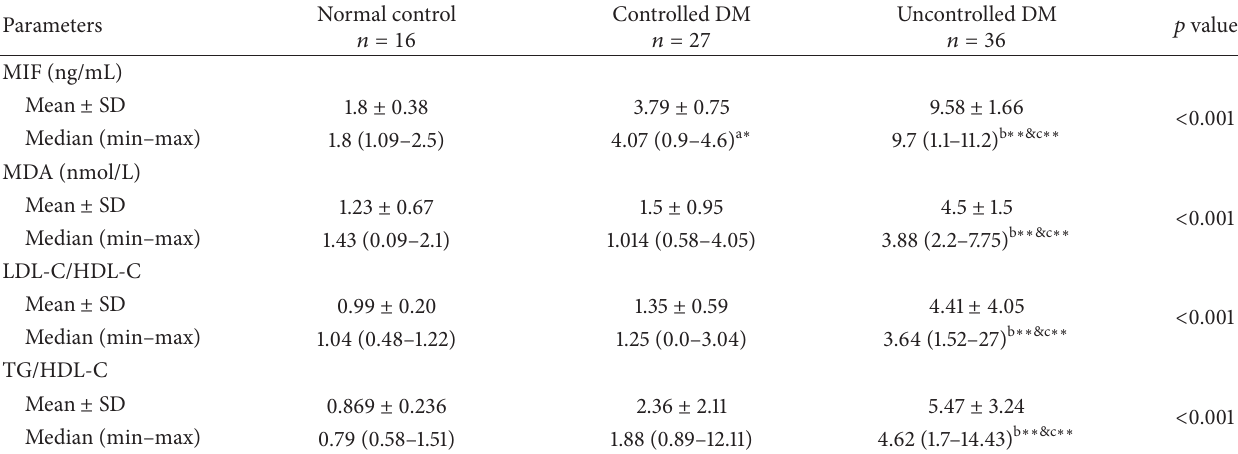
Table 2: Levels of the studied potential predictors of diabetic complications in the different group.